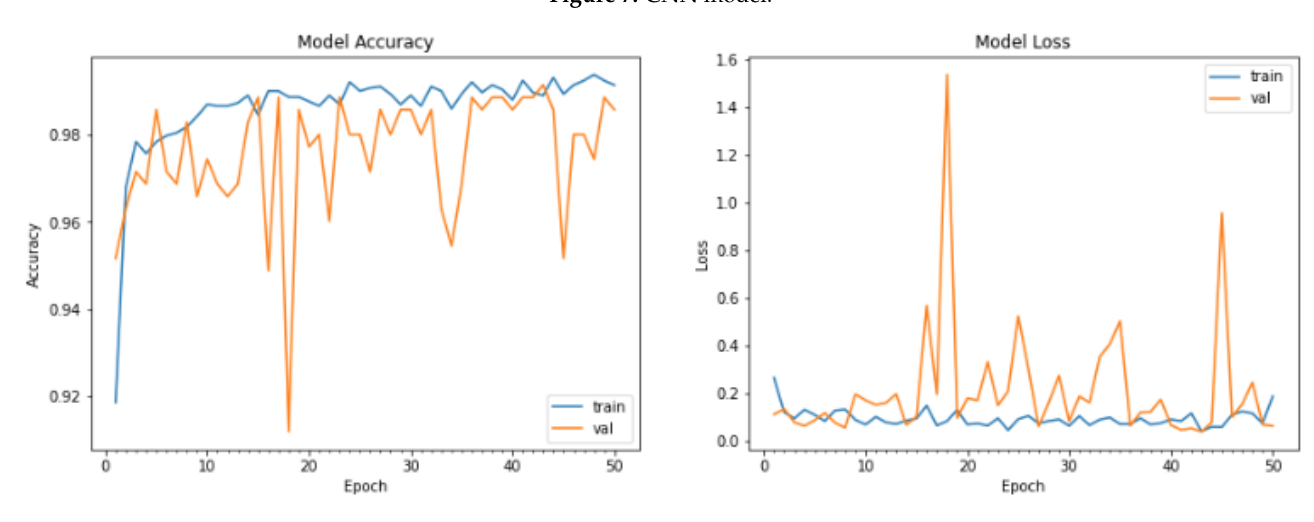
Figure 7. CNN model.